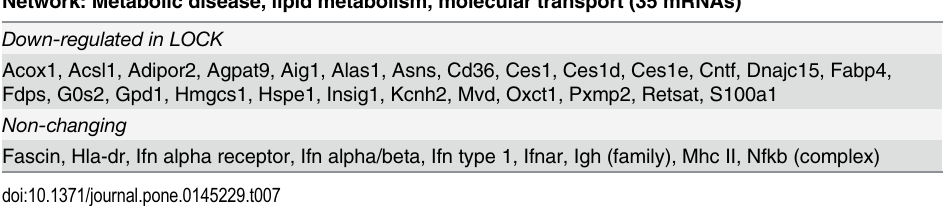
Table 7. List of transcripts from top scoring IPA network inclusive of only down-regulated genes as influenced by wheel locking (LOCK) (score = 58). Network: Metabolic disease, lipid metabolism, molecular transport (35